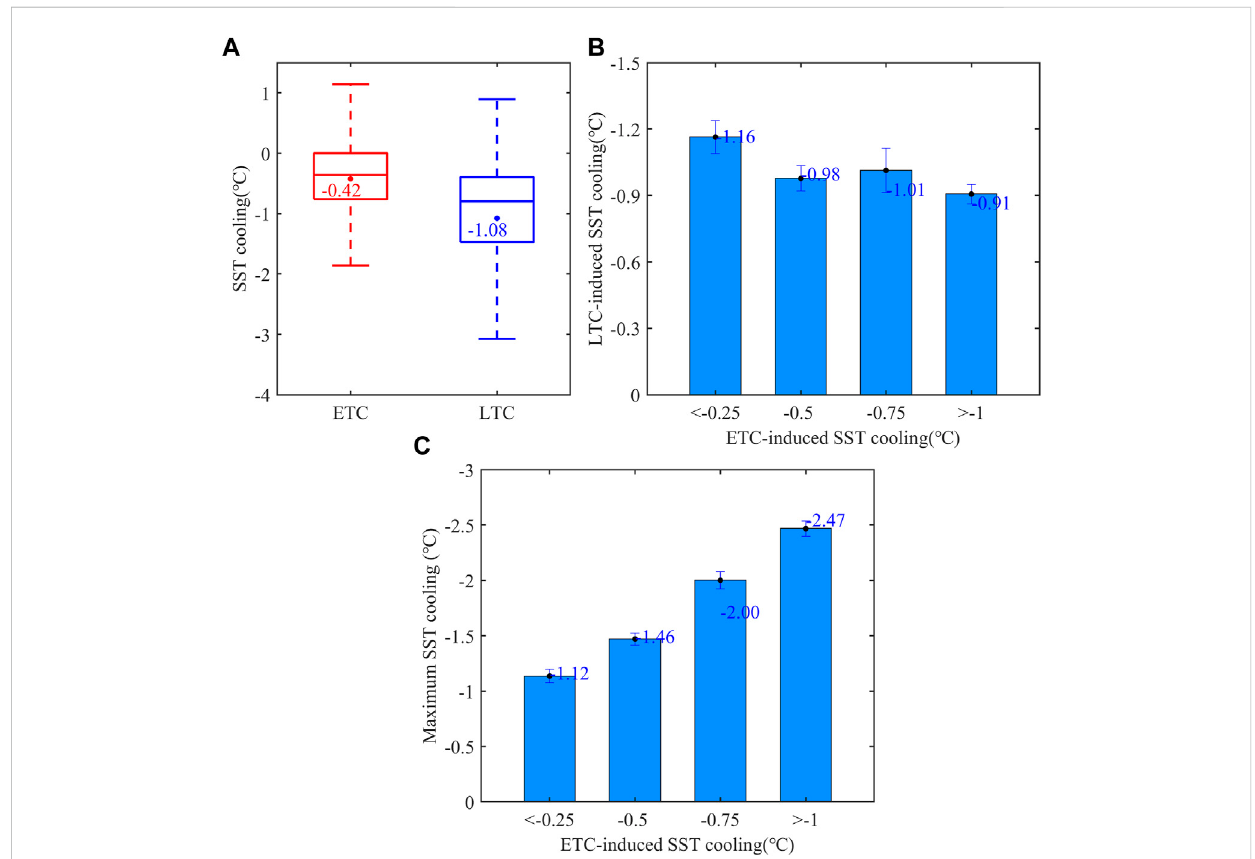
FIGURE 5 The boxplot of the ETC-induced SST cooling and the LTC-induced SST cooling (A) during the passage of sequential TCs and (B) the mean SST coolinginducedbytheLTCandthesequentialTCsand (C) asafunctionoftheETC-inducedSSTcooling.Insubgraph (A) ,thedotsintheboxesdenotethe averagevaluesofSSTcooling.ThedegreetowhichtheLTC-inducedSST coolingislargerthantheETC-inducedSSTcoolingissigni fi cantabovethe95% con fi dence level based on the Student ’ s